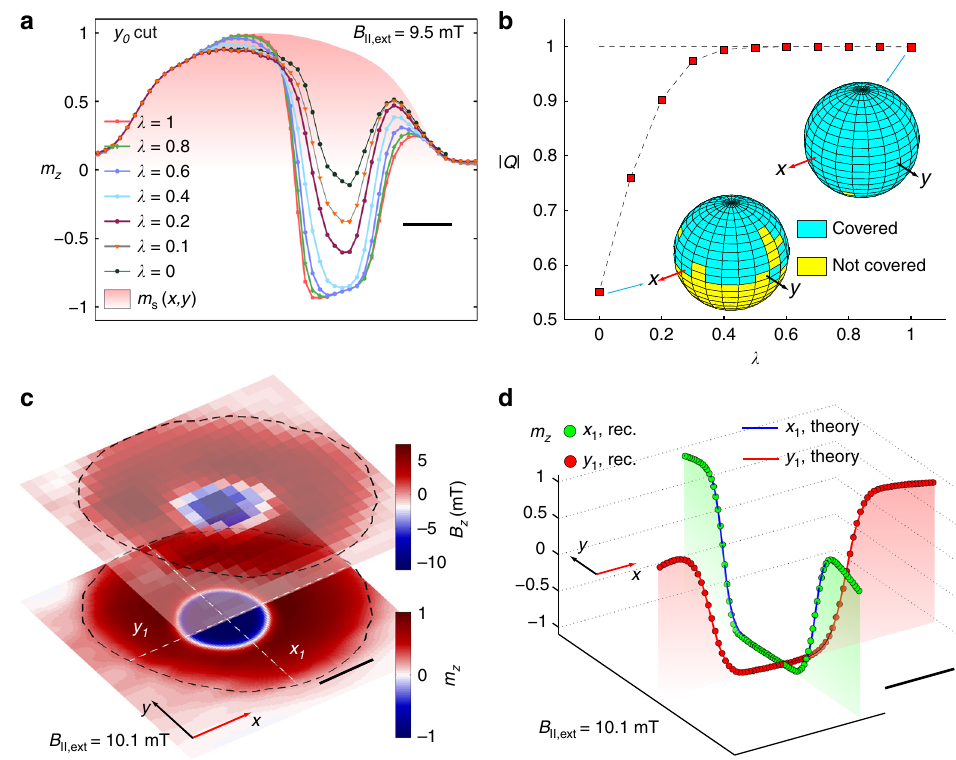
Fig. 4 Topology of the reconstructed magnetic structure. a Continuous tuning of the magnetic structure from the Bloch to the Néel gauge as a function of the parameter λ (see text for details). The m z pro fi les reported here are cuts along the y = y 0 line shown in Fig. 3b. The fi lled shaded region represents the spatial variation of the normalized saturation magnetization, namely the m z pro fi le given by the fi lled red markers in Fig. 3f. b Absolute value of the topological number de fi ned in Eq. (2), for each of the spin con fi gurations shown in a . The number Q can be visualized as the number of times the vector fi eld wraps around a unit surface. Therefore, the inset shows the stereographic projection of the vector fi eld on a sphere. The image illustrates that only Néel-like con fi gurations have integer Q . c Map of the B z component of the stray fi eld (upper sheet) and reconstructed m z magnetization (lower sheet) for a skyrmion nucleated at the centre of the magnetic disc. The black dashed lines represent the disc boundary. The scan was measured with a bias fi eld parallel to the NV axis of B ||,ext = 10.1 mT. d Comparison of the reconstructed m z skyrmion pro fi le (markers) with a domain wall model for the skyrmion (solid lines). The pro fi les are cuts through the x = x 1 and y = y 1 directions shown in Fig. 4c. Spatial variation of the saturation magnetization is taken into account and the skyrmion pro fi le is observed to be round. The scale bar is 200 nm in a , d , and 300 nm in c